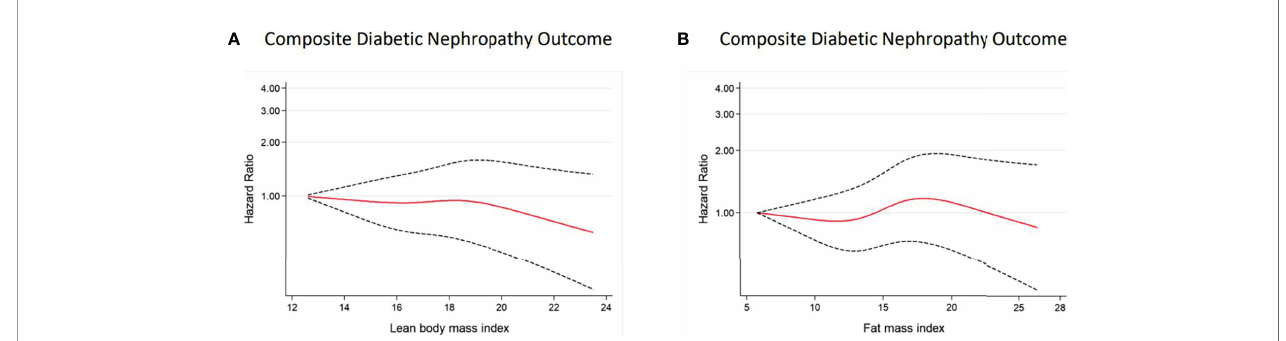
FIGURE 3 | Multivariable-adjusted hazard ratios of incident DN for predicted LBMI (A) and predicted FMI (B) among women with diabetes. Curves represent adjusted hazard ratios for DN based on restricted cubic splines with knots placed at 5th, 35th, 50th, 65th, and 95th centiles. Models were adjusted for baseline age, race, glycaemia, BP vs lipid, diabetes duration, alcohol, cigarette, hypertension history, stroke history, and CVD history. Predicted LBMI and predicted FMI were mutually adjusted. The solid red line represents the hazard ratio, and the dashed black lines represent the 95% con fi dence intervals for the association between LBMI or FMI and DN